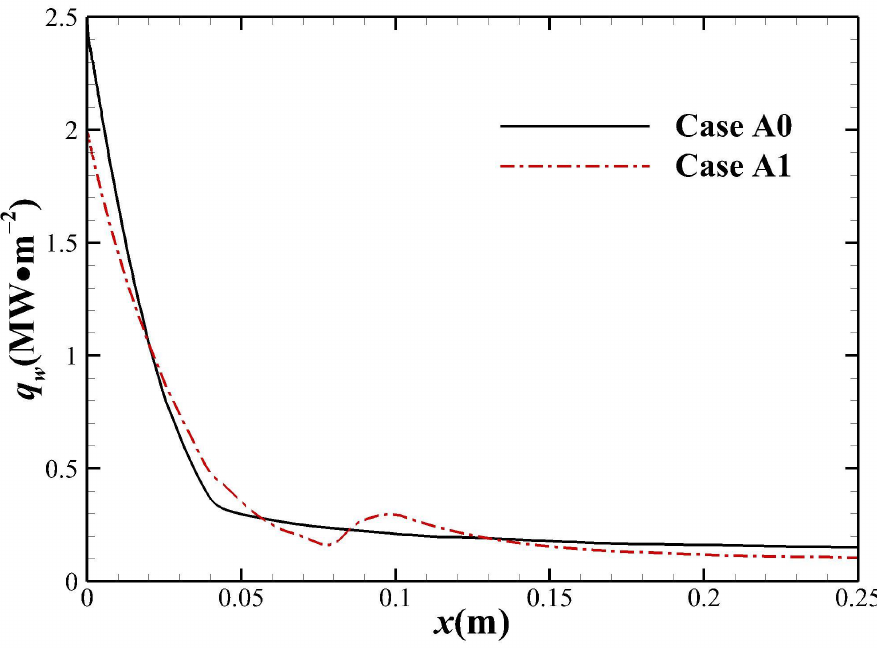
Figure 11. Comparison of surface heat flux distribution.